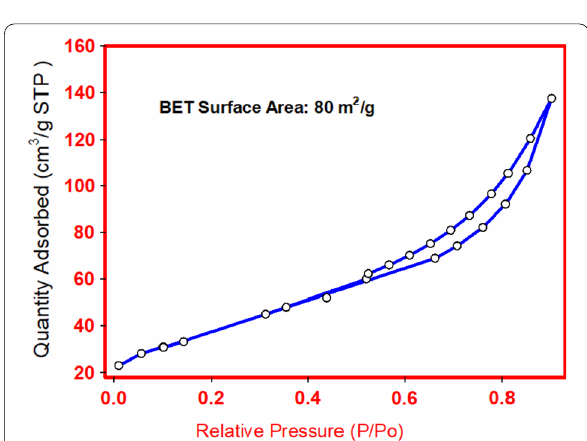
Fig. 4 The isotherms of nitrogen adsorption on the surface of the sodium titanate